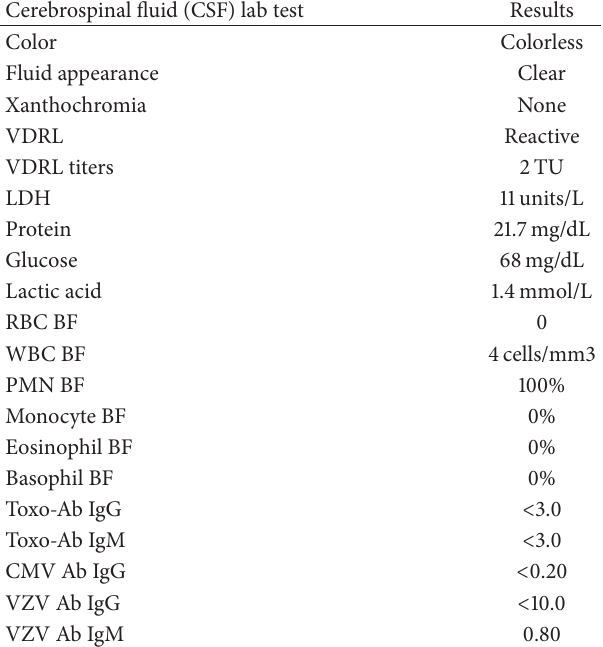
Cerebrospinal fluid (CSF) lab test